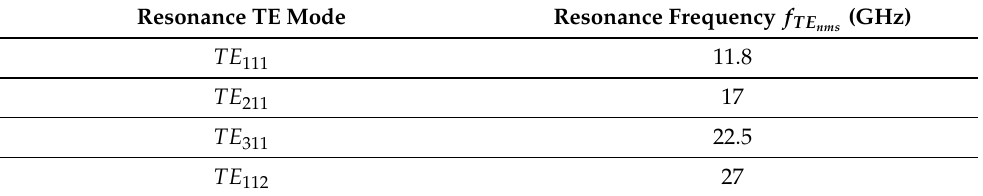
Table 1. Resonance frequencies of several TE modes of the used alumina hemispherical DRA.